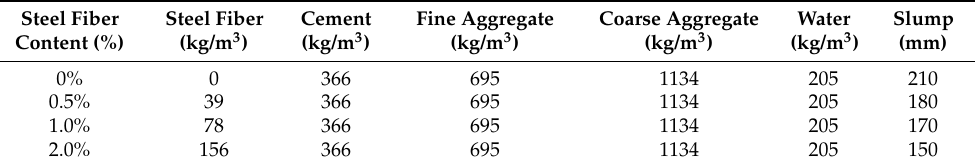
Table 2. Mixture proportion for concrete.